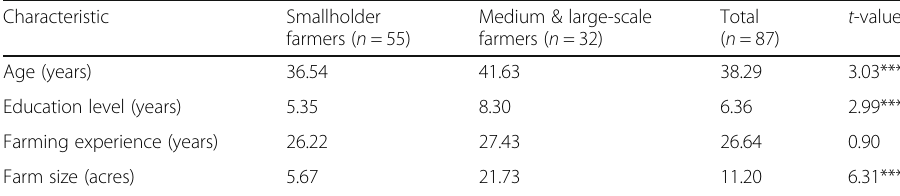
Table 1 Characteristics of Farmers Group Characteristic